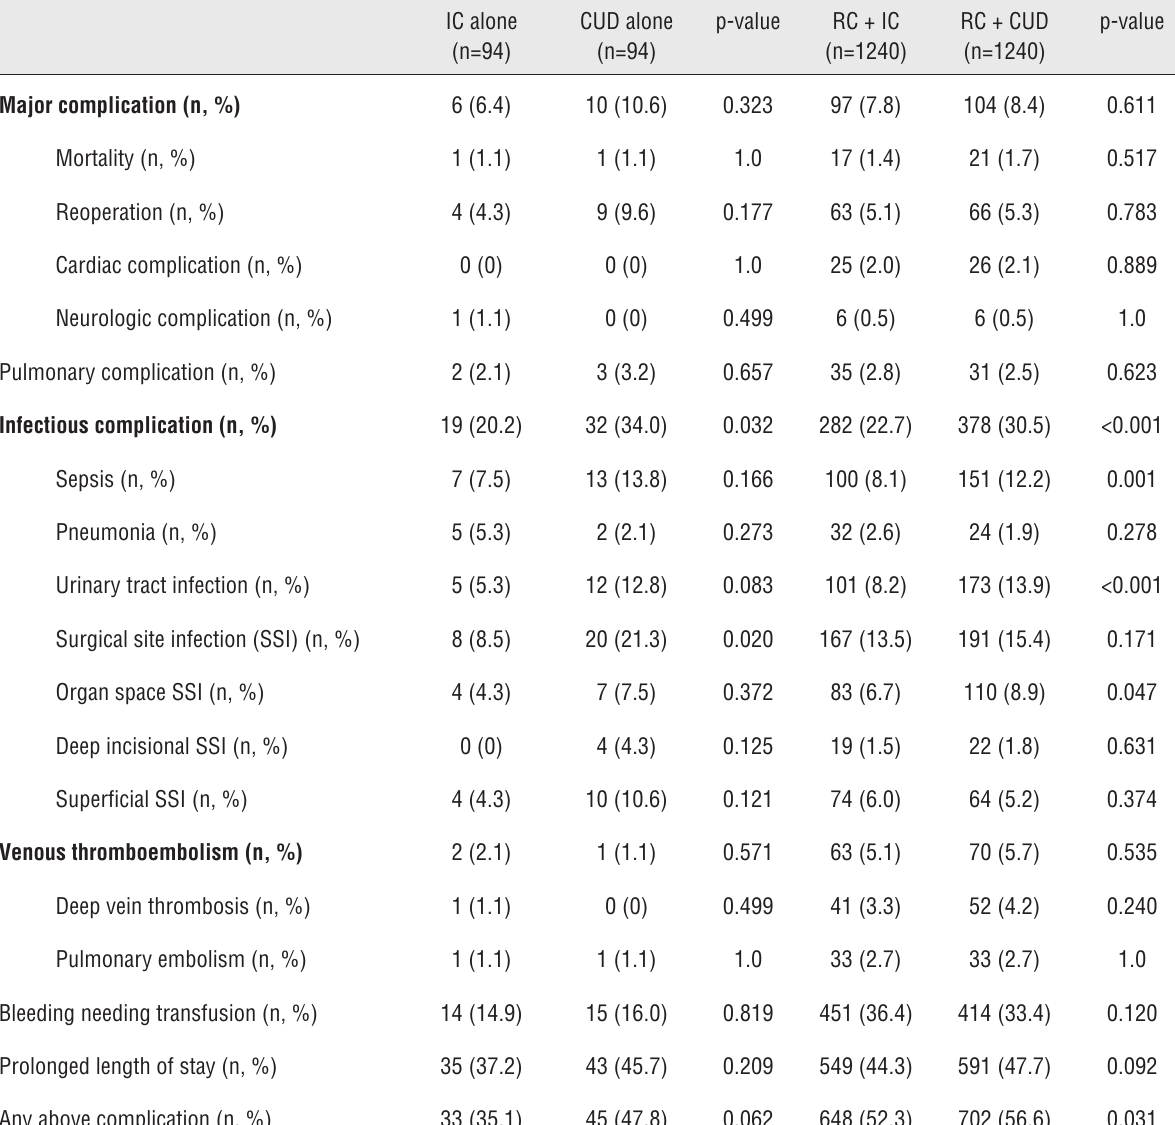
Supplemental Table 5 - Rates of complications after propensity score matching – Comparison of IC vs. CUD, with and without